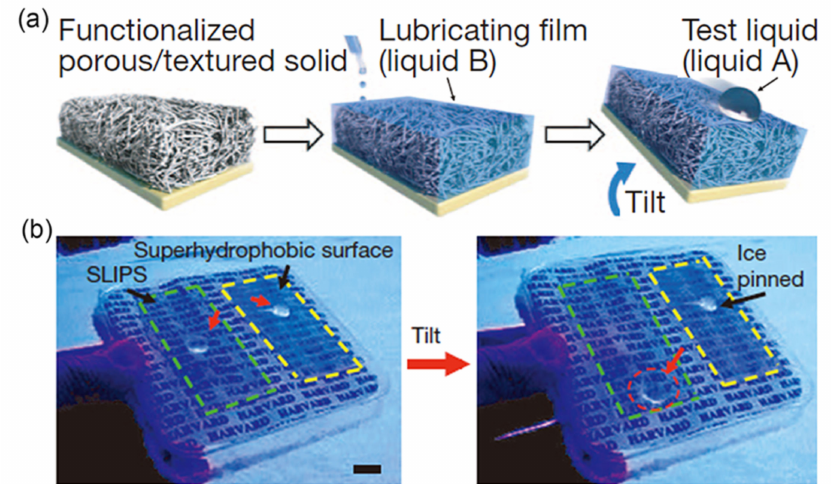
Figure 8. ( a ) Schematics showing the fabrication of a SLIPS by infiltrating a functionalized porous/textured solid with a low-surface energy, chemically inert liquid. ( b ) Ice mobility on a SLIPS (highlighted in green) compared to strong adhesion to an epoxy-resin-based nanostructured su- perhydrophobic surface (highlighted in yellow) when temperature and relative humidity were − 4 ◦ C and ~45%, respectively. ( a , b ) Reproduced with permission from [209], Copyright 2011 Macmillan Publishers